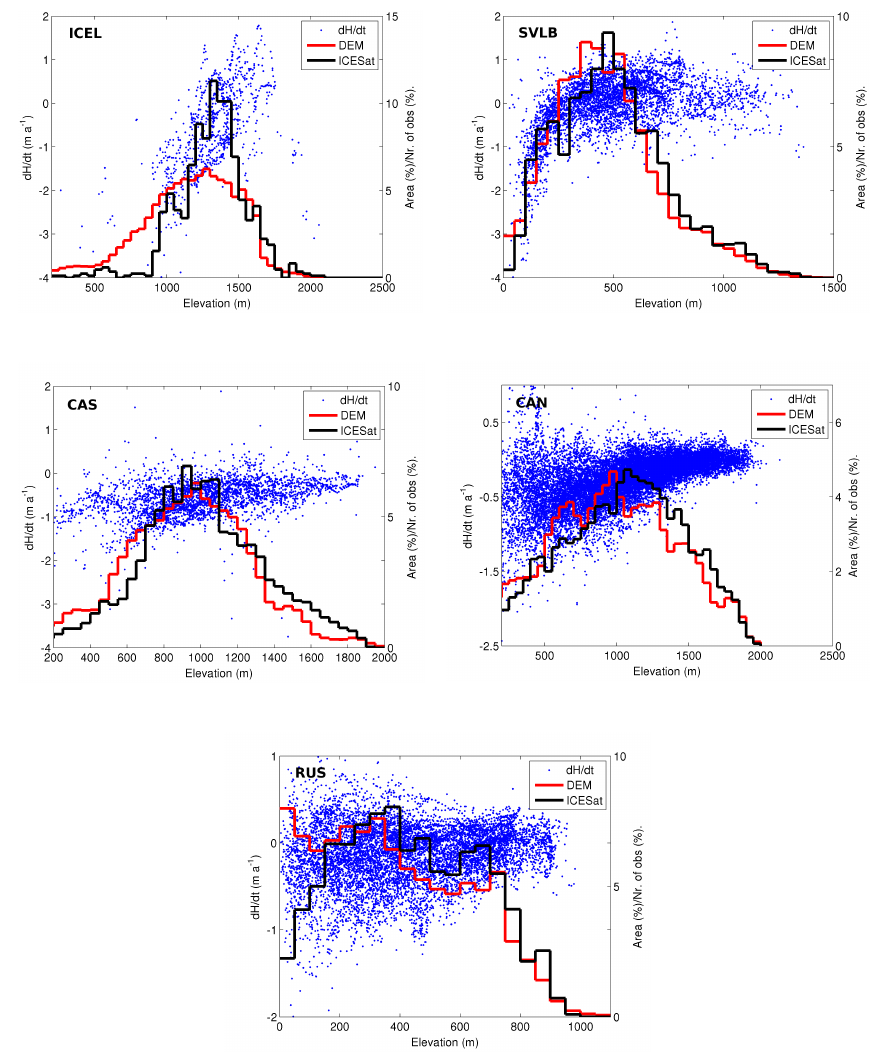
Figure 3. Elevation change (blue points) as a function of elevation for the different Arctic regions, which are used for the regional ex- trapolation. The black curve represents the density of ICESat’s sampling and the red curve the DEM hypsometry, both per 50m elevation